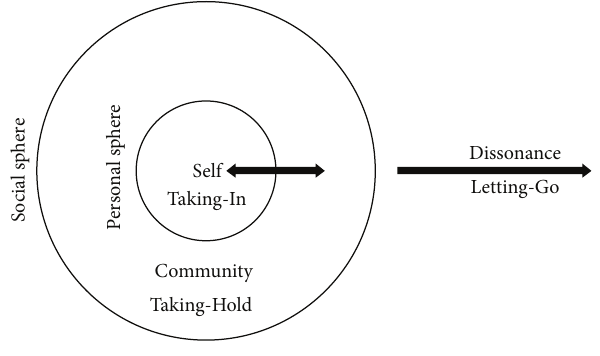
Figure 2: Social Connection System.